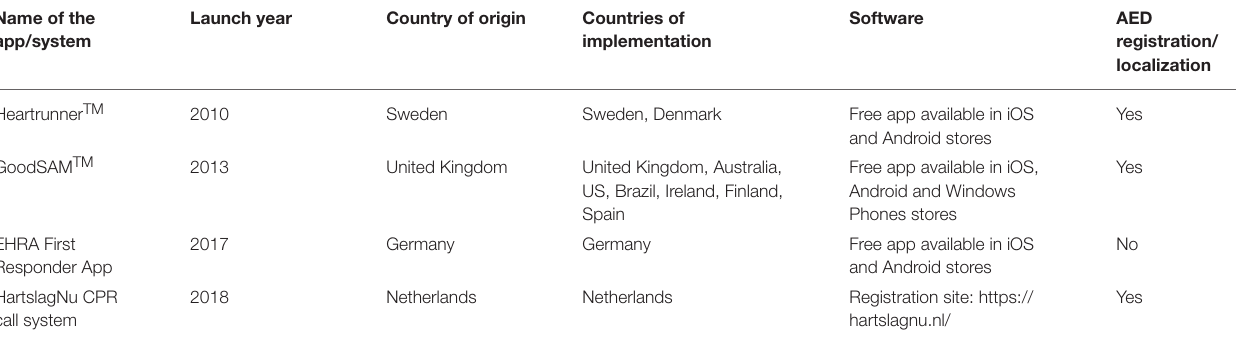
TABLE 2 | First responder notification and contactless cardiac arrest detection systems using smart devices. Name of the